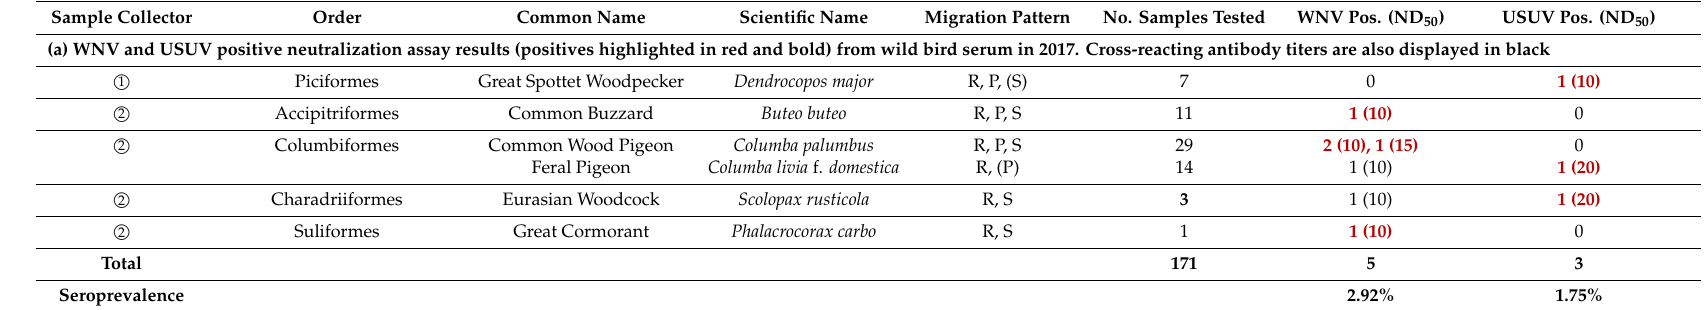
Table 4. WNV- and USUV-positive neutralization assay results from wild bird serum samples Region A—Northern